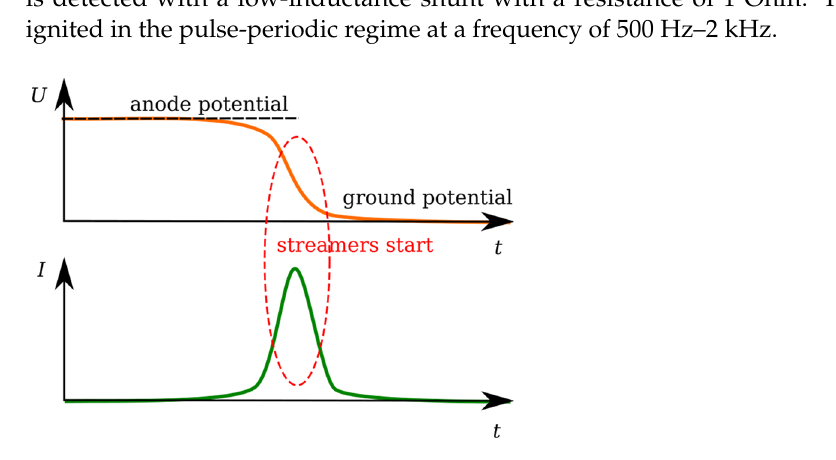
Figure 2. Schematic representations of waveforms of cathode voltage ( 𝑈 ) with respect to ground and current ( 𝐼 ) in the cathode-to-ground circuit.